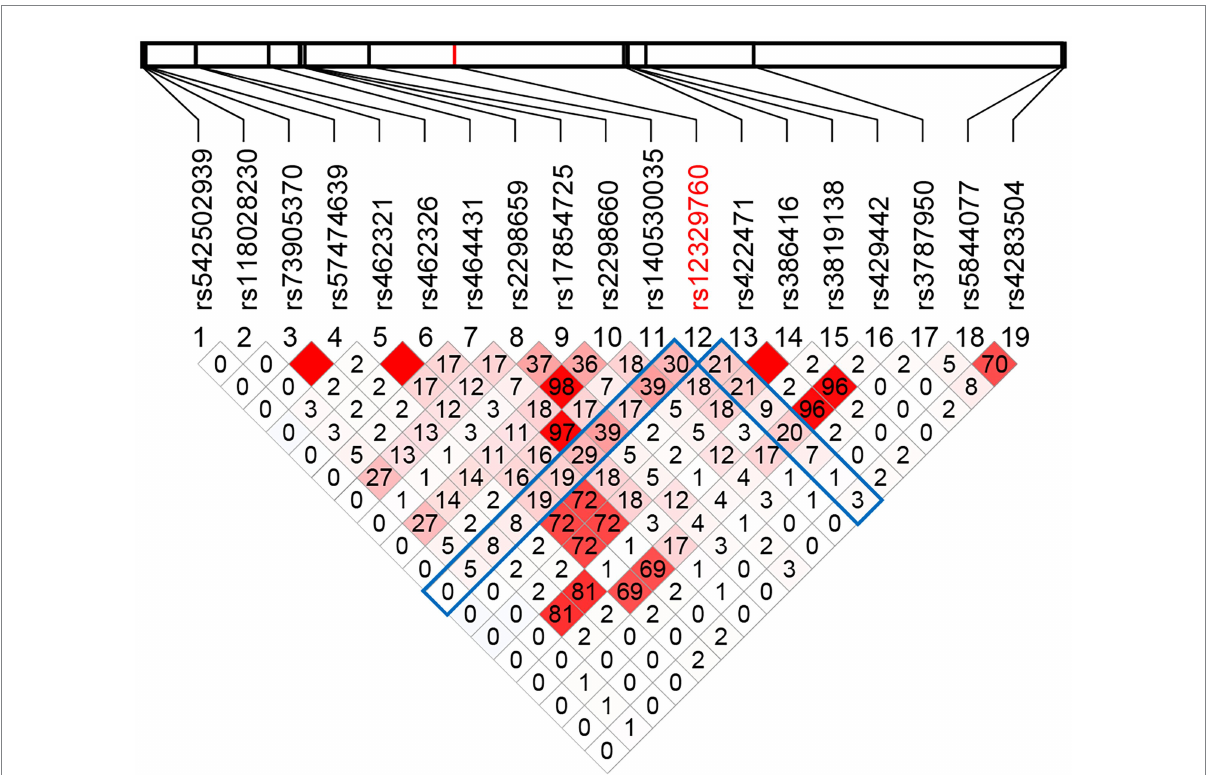
FIGURE 1 The linkage disequilibrium of the 19 common SNPs within the TMPRSS2 locus in East Asian populations. The linkage disequilibrium of the 19 common SNPs within the TMPRSS2 locus in East Asian populations was analyzed using the genotype data from 1,000 Genomes Project. The physical position of each SNP is shown above the plot. The values of r 2 × 100 are shown in the boxes. The square without number corresponds to r 2 = 1.0. The red scale represents the LD status between each pair of SNPs ( r 2 = 1 red; r 2 = 0 white).